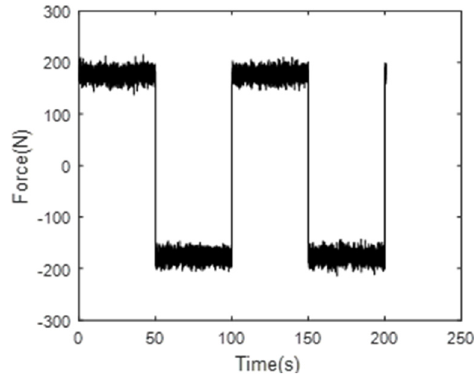
Figure 13. The force value of 60 mm and 0.01 Hz.